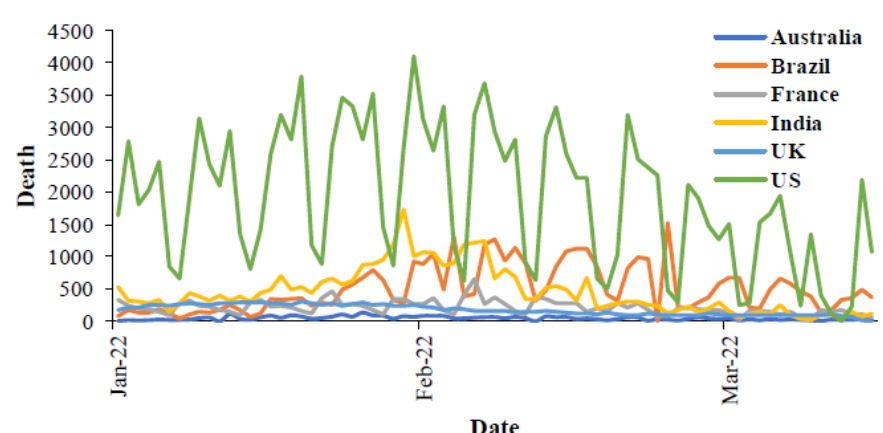
Figure 17. Mortality during the Omicron outbreaks in Australia and the most affected countries from 6 January to 21 March 2022 [64].